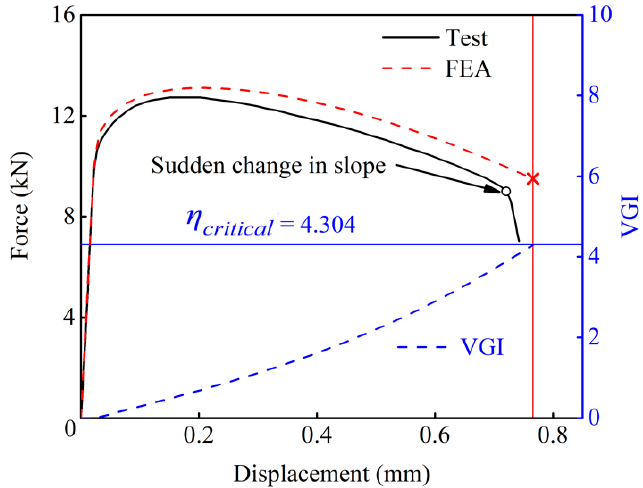
Figure 13. Lode-displacement curve and VGI evolution of the shear-tension specimen.